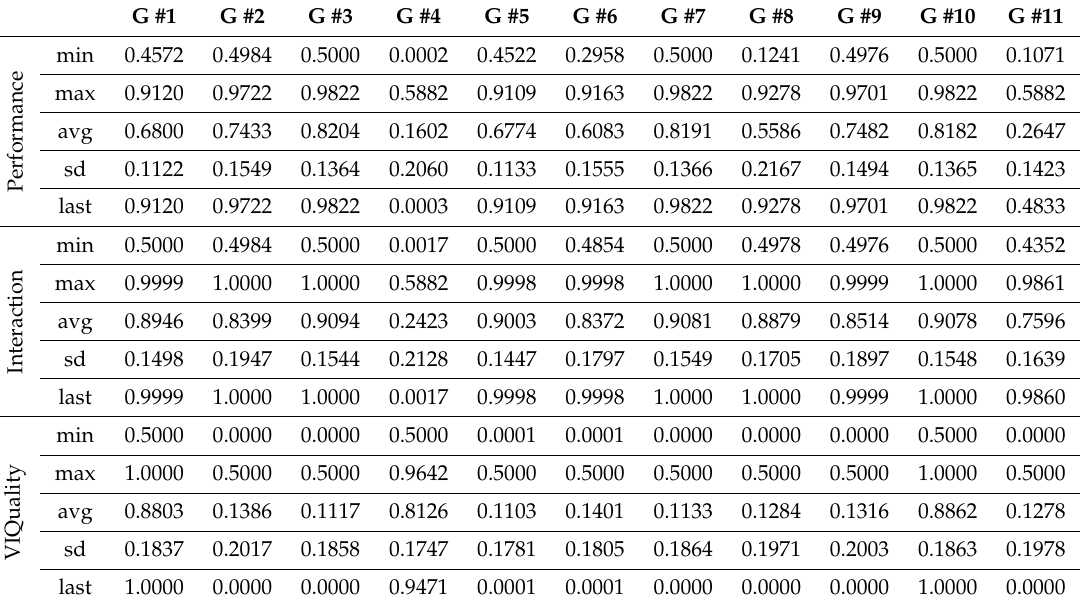
Table 9. Barthel test results associated to the tests in Table 8 (see text for